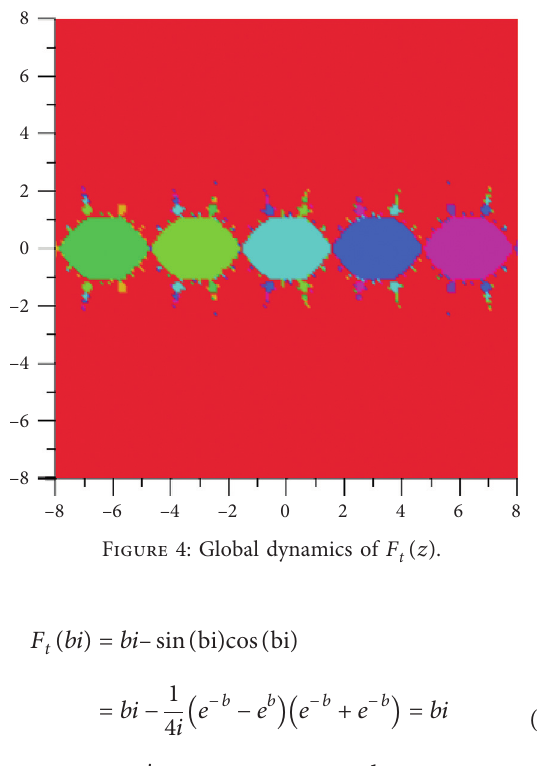
( z ) and (b) the fractal boundary of F s